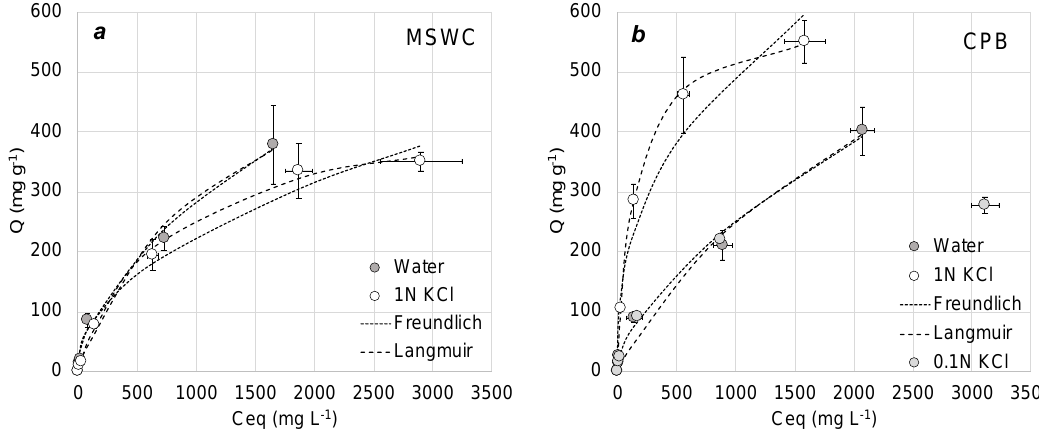
Figure 4. Adsorption curves in presence and absence of 1 M KCl for ( a ) municipal solid waste compost (MSWC) and ( b ) composted pine bark (CPB). Bars show standard deviation of the mean (n = 3).